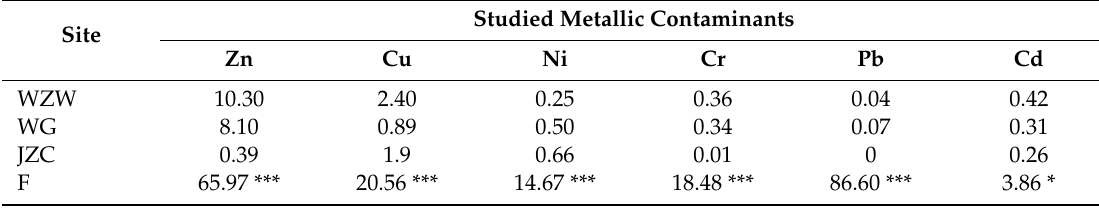
Table 2. Inter-site comparison of mean values of biota–sediment accumulation factors (BSAF) of bivalves among the three study sites, i.e., WZW, WG and JZC, along Danshuei Riverine Mangrove. Site Studied Metallic Contaminants Site Zn Cu